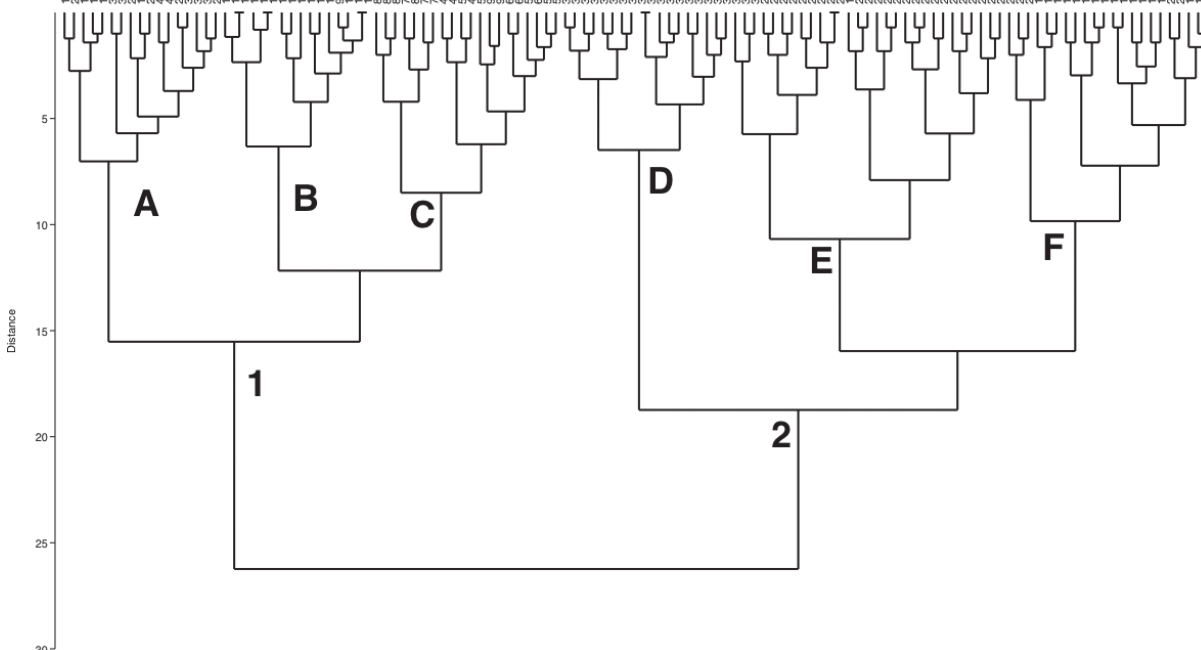
Figure 4. Ward dendrogram of date palm cultivars based on SSR and EST-SSR